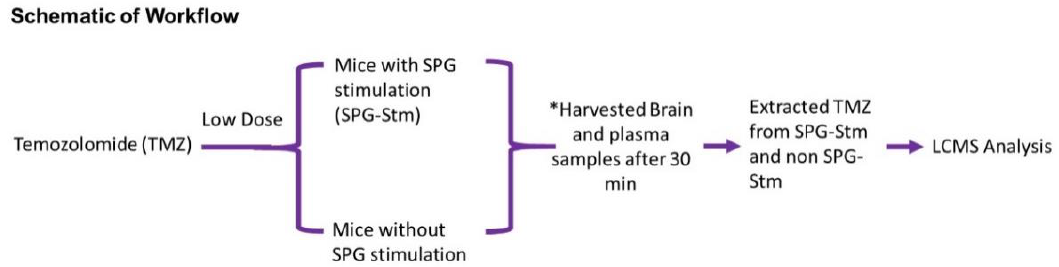
Figure 2. Schematic workflow of the study conducted for mapping the concentration of TMZ in the sphenopalatine ganglion (SPG) stimulated rats using LCMS. Asterisk denotes same protocol for both groups.